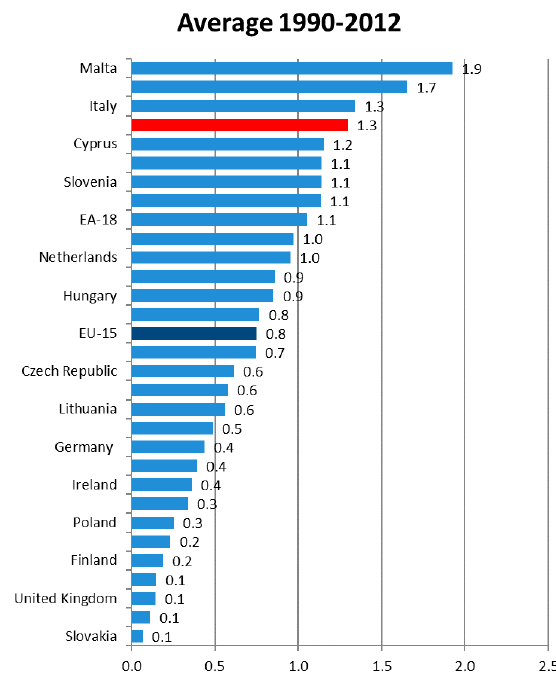
Figure 1. Elasticity of Electricity Demand to GDP ( ∆ Demand/ ∆ GDP). Source: Own calculations with Eurostat data.